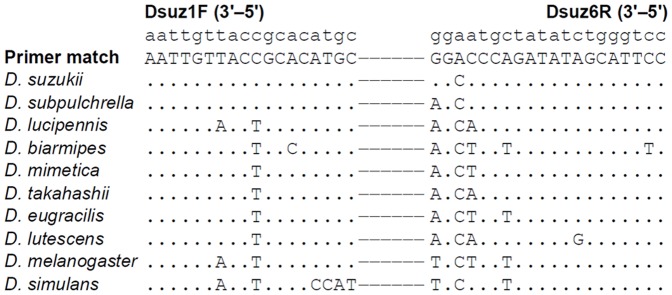
Real-time PCR assay for the identification of Drosophila suzukii primer pair alignment with closely related species.There is a mismatch in the reverse primer target sequence match at the 3′ end and non-target sequence D. subpulchrella (G → A), due to SNP-1. An additional mismatch was introduced in the reverse primer at third base from the 3′ end (A → C) to further suppress the binding of D. subpulchrella.